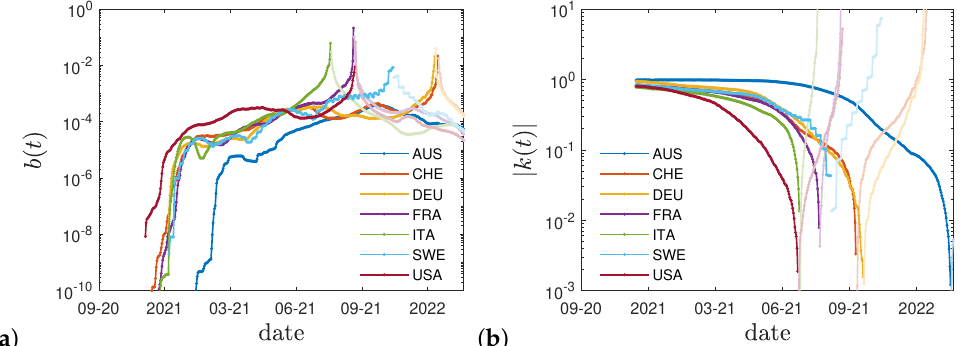
Figure 5. Dimensionless ratios (a) b ( t ) and (b) k ( t ) evaluated using Equation (24) and the data shown in Figures 3 and 4. As in Figure 2, regimes with k ( t ) < 0, here also b ( t ) , are indicated by light color. The raw data were retrieved from